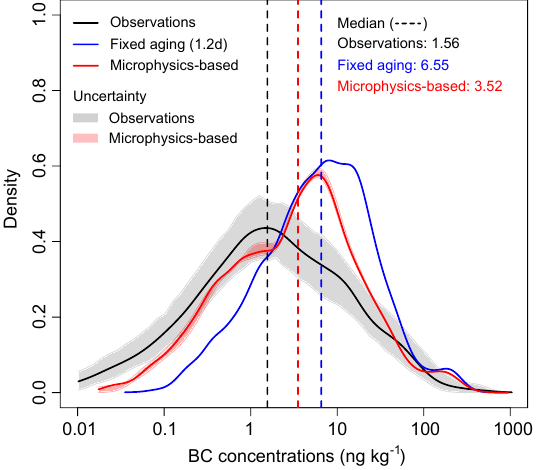
Figure 5. Probability density functions of HIPPO observed (black) and GEOS-Chem simulated BC concentrations. Model results using a fixed BC aging (blue) and a microphysics-based aging (red) are shown. The 95% uncertainty range of the HIPPO observations, es- timated from a Monte Carlo method, is shown (in grey). Also shown (in light red) is the range of model results from microphysics- based sensitivity simulations (see Table 1 and text for details). Dashed lines show the median of observations (1.56ngkg − 1 , black), fixed aging (6.55ngkg − 1 , blue), and microphysics-based aging (3.52ngkg − 1 , red). About 5% of the observed BC concen- trations are below 0.01ngkg − 1